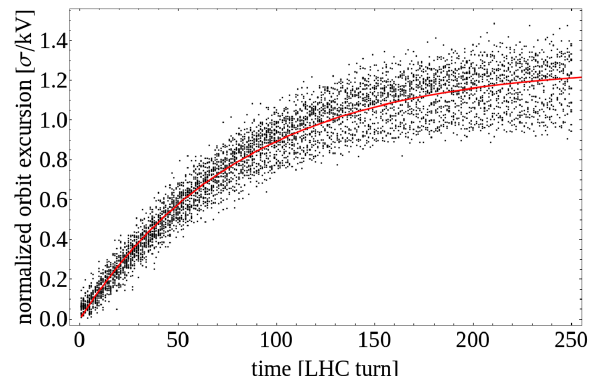
FIG. 21. Measured coherent excitation of the beam by the ADT, normalized to the applied voltage. The beam energy was 6.5 TeV, and the data consists of 26 separate measurement series of varying duration. Note that the orbit excursion ( σ ) in this plot is based on a normalized emittance of 3 . 5 μ m · rad. Each point is the orbit excursion on a given turn in each of the 26